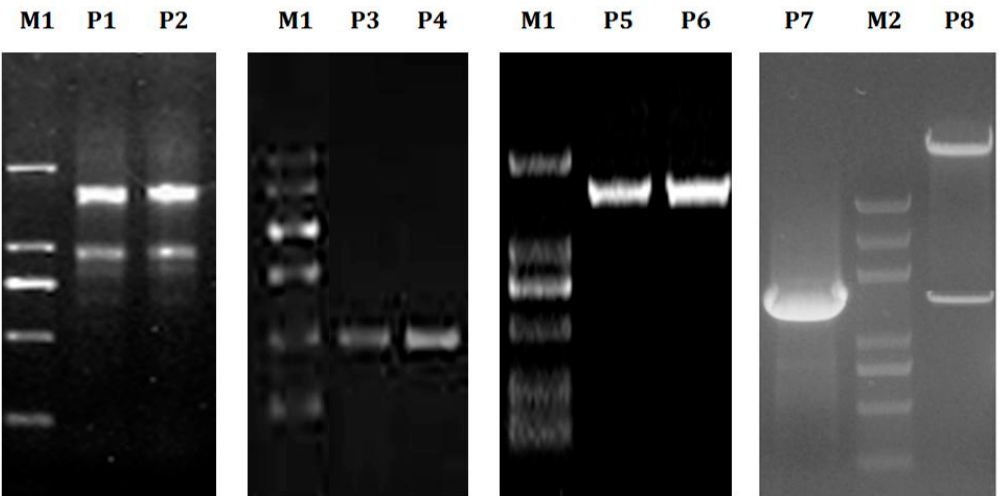
Figure 7. LoSUT clone electrophoresis gel map. M1: marker1: The molecular weights in order from large to small: 2000, 1000, 750, 500, 250, 100 bp; M2: marker2 The molecular weights in order from large to small: 5000, 3000, 2000, 1000, 750, 500, 250, 100 bp; P1, P2: RNA Bands; P3, P4: SUT fragment clone; P5, P6: SUT full length cloning; P7: SUT gene bacteria PCR; P8: BamHI digestion of expression vector pBI121 through XbaI.